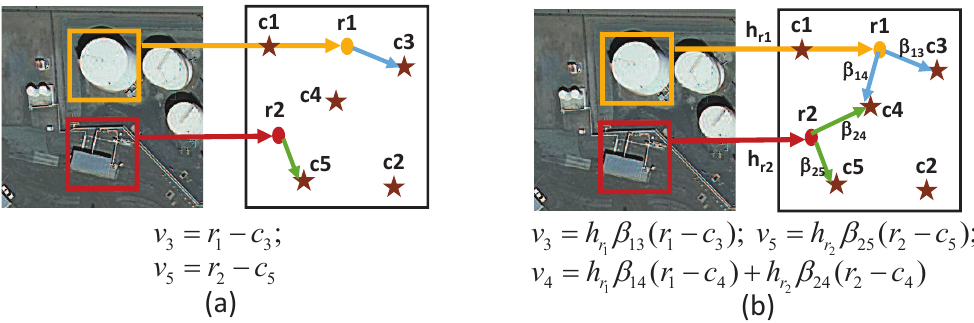
Figure 3. The comparison of original VLAD (Vector of Locally Aggregated Descriptors) and the improved VLAD descriptors generation: ( a ) original VLAD with nearest neighbor assignment; ( b ) the improved VLAD with weighted multi-neighbor